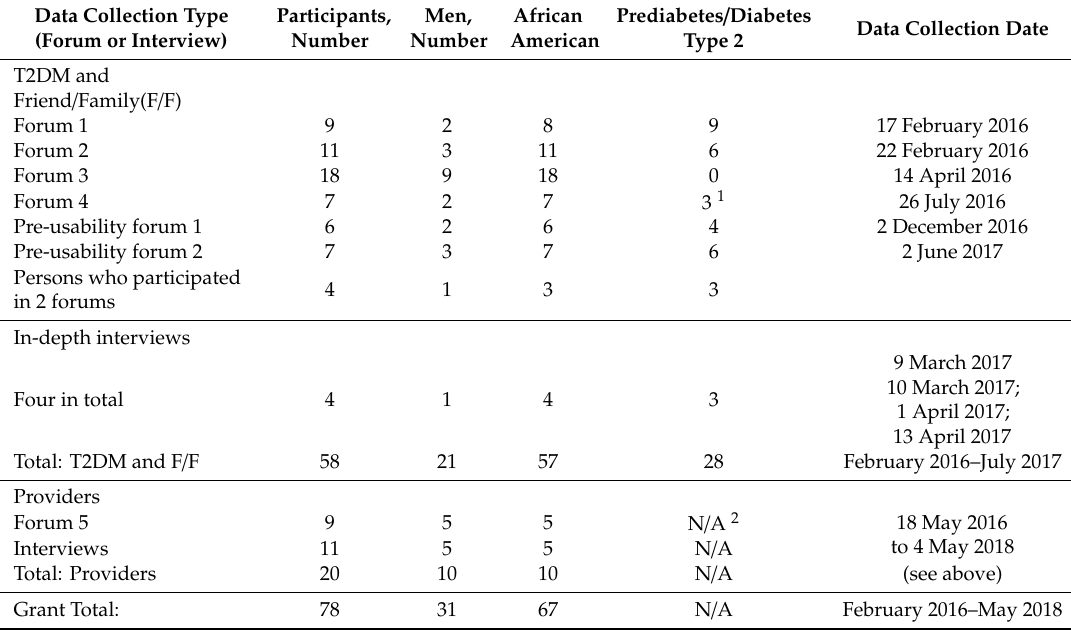
Table 1. Participant characteristics of persons with prediabetes, Type-2 diabetes (T2DM), and friend and family member participant characteristics and types of data collection, n =